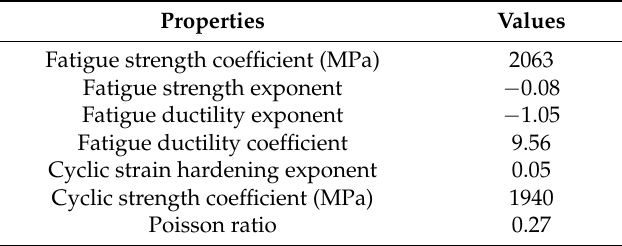
Table 3. Cyclic properties of the carbon steel